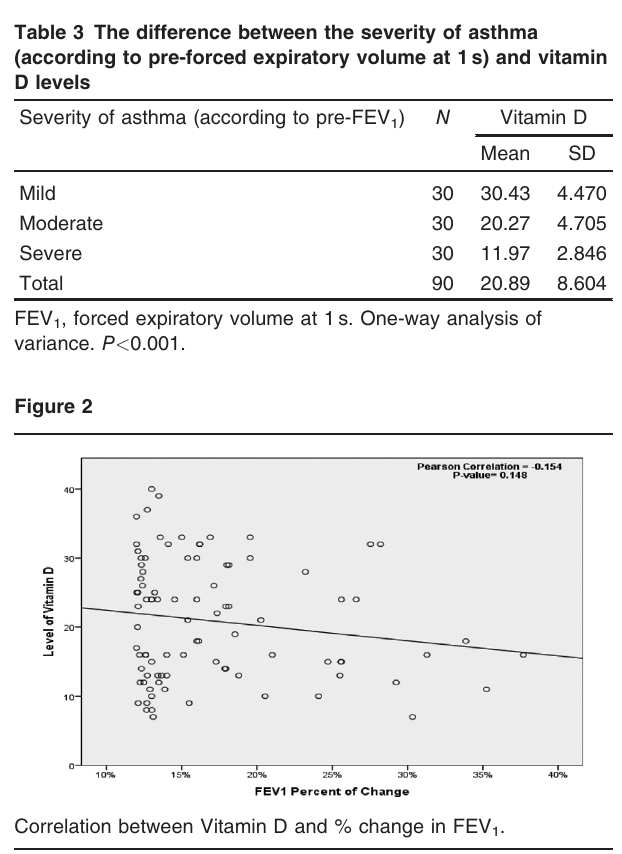
Correlation between Vitamin D and % change in FEV 1 .